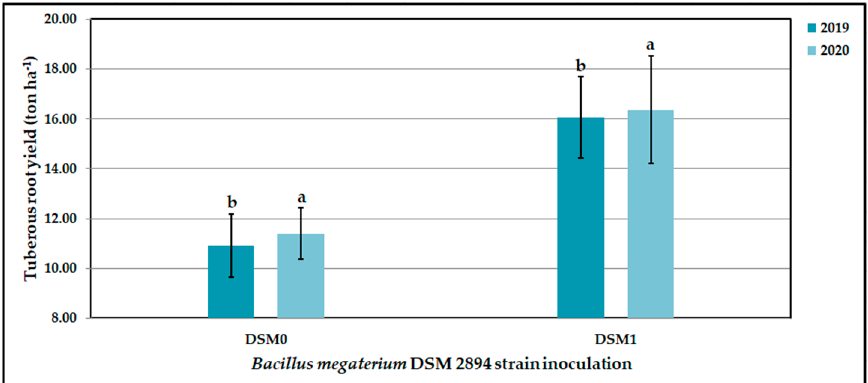
Figure 22. Influence of Bacillus megaterium DSM 2894 var. on total root yield of CaCO 3 ‐ stressed sweet potato plants grown in 2019 and 2020 seasons. Bars with a different letter indicate significant different between treatments at p ≤ 0.05. DSM 0 = non-inoculated with Bacillus megaterium DSM 2894 var., DSM 1 = inoculated with Bacillus megaterium DSM 2894 var.